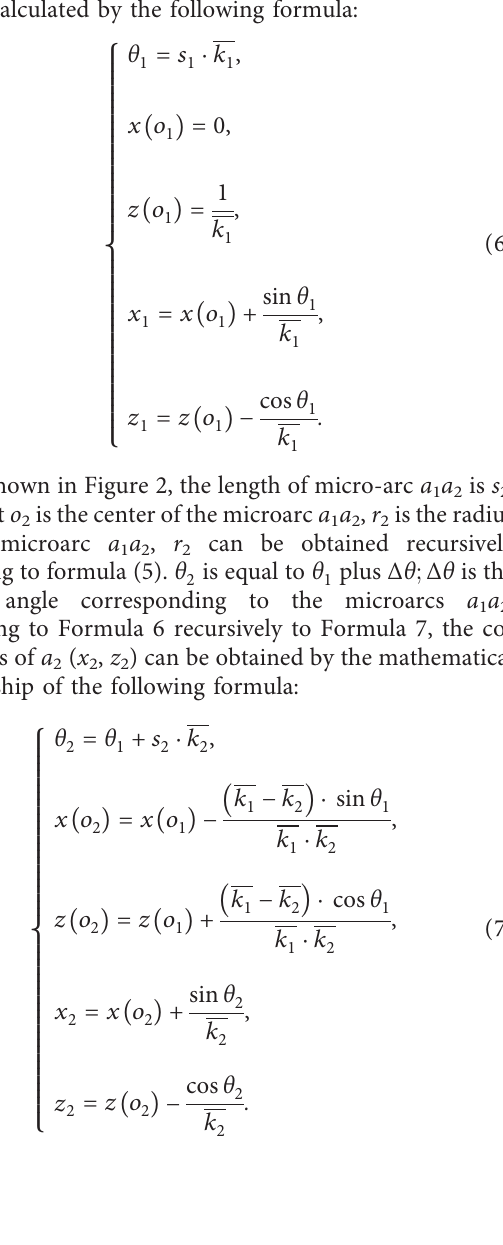
Figure 2: Discrete curvature reconstruction curve based on re- cursion